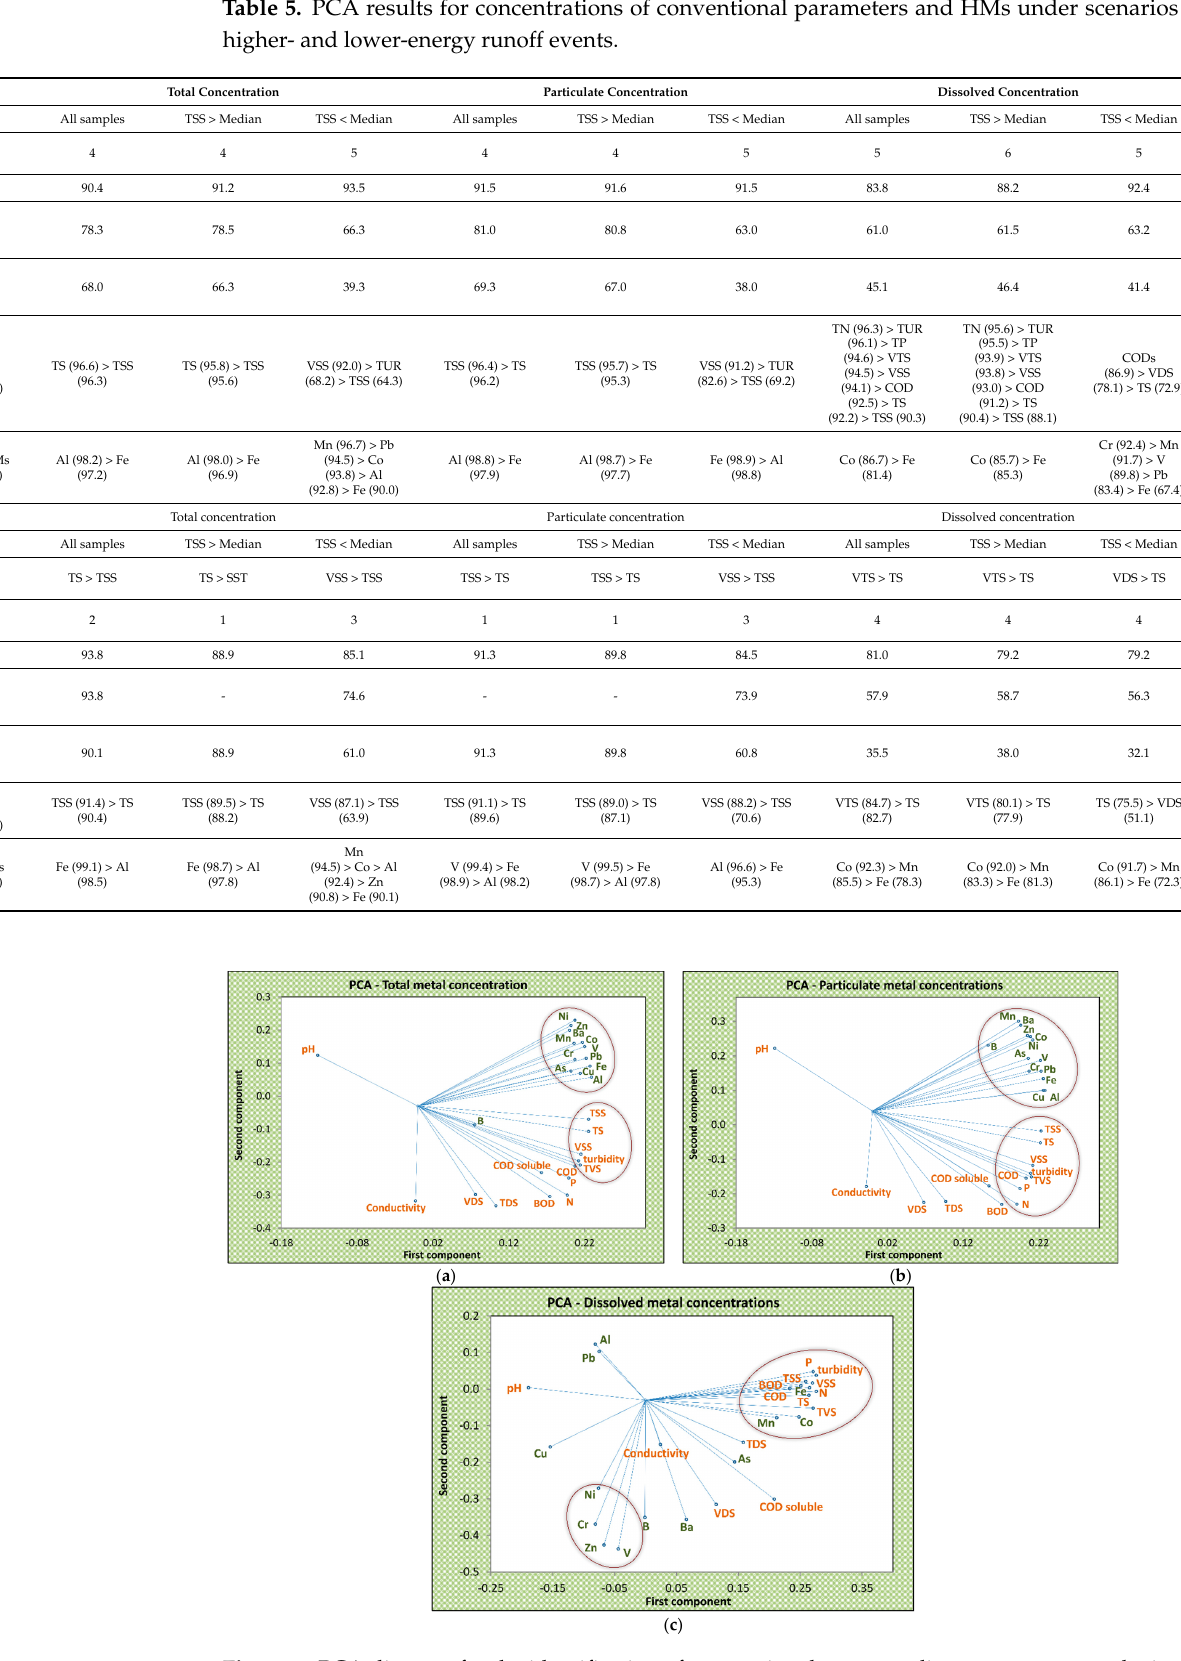
Figure 2. PCA diagram for the identification of conventional water quality parameters as substitutes for the ( a ) total, ( b ) particulate, and ( c ) dissolved HM concentration in road